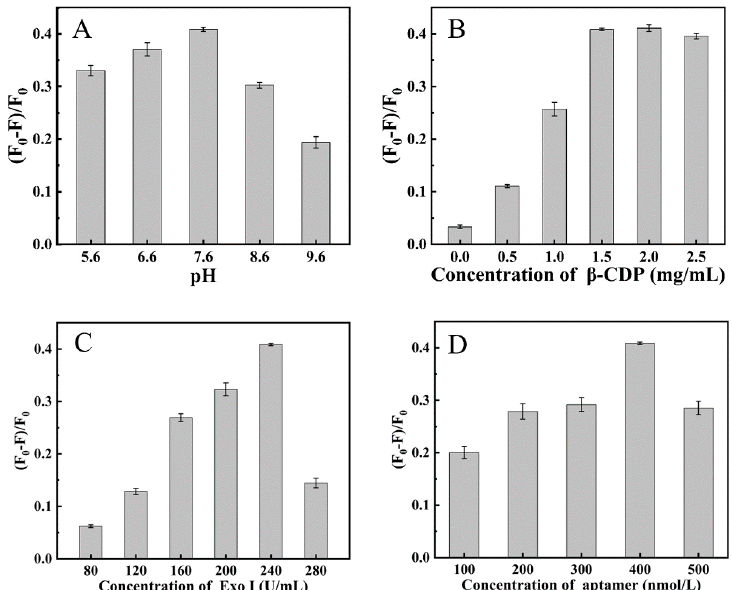
Figure 5. ( A ) Optimization of pH value. The activity of Exo I was 240 U/mL. The concentration of N protein, aptamer, and β -CDP was 200 nM, 400 nM, and 1.5 mg/mL, respectively. ( B ) (F 0 − F)/F 0 vs. the concentration of β -CDP. The activity of Exo I was 240 U/mL. The concentration of N protein and aptamer was 200 nM and 400 nM, respectively. ( C ) (F 0 − F)/F 0 vs. the activity of Exo I. The concentration of aptamer was 400 nM. The concentration of N protein was 200 nM. The concentration of β -CDP was 1.5 mg/mL. ( D ) (F 0 − F)/F 0 vs. the concentration of aptamer. The concentration of Exo I and N protein were 240 U/mL and 200 nM, respectively. The concentration of β -CDP was 1.5 mg/mL. Error bars indicated the standard deviations of three experiments.